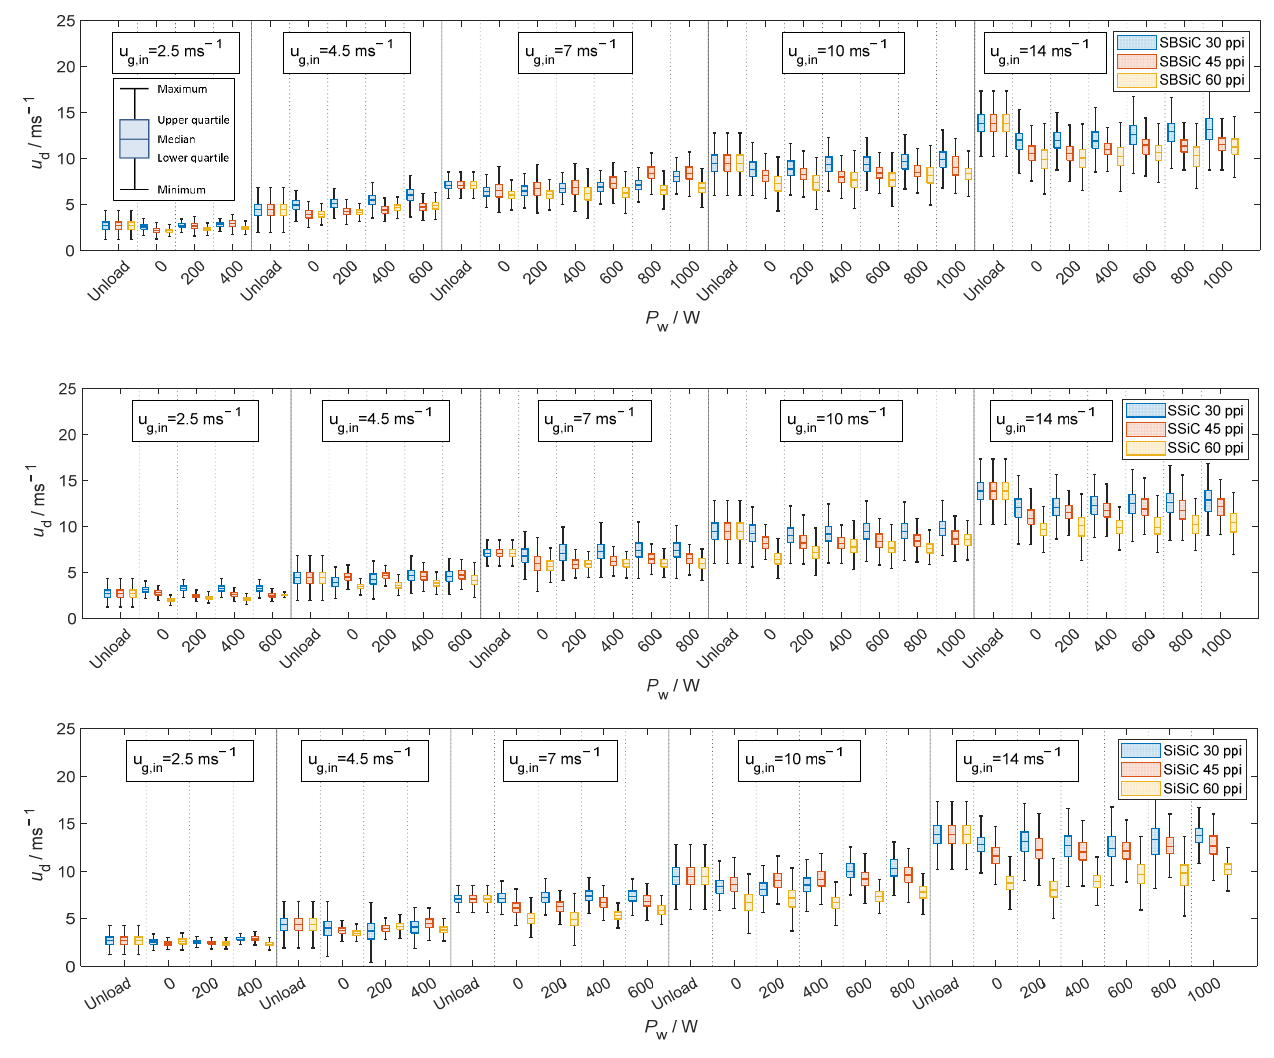
Figure 9. Velocity of droplets crossing the outlet position of the microwave applicator loaded with SBSiC ( top ), SSiC ( middle ) and SiSiC ( bottom ) foams at an input magnetron power up to 1 kW.